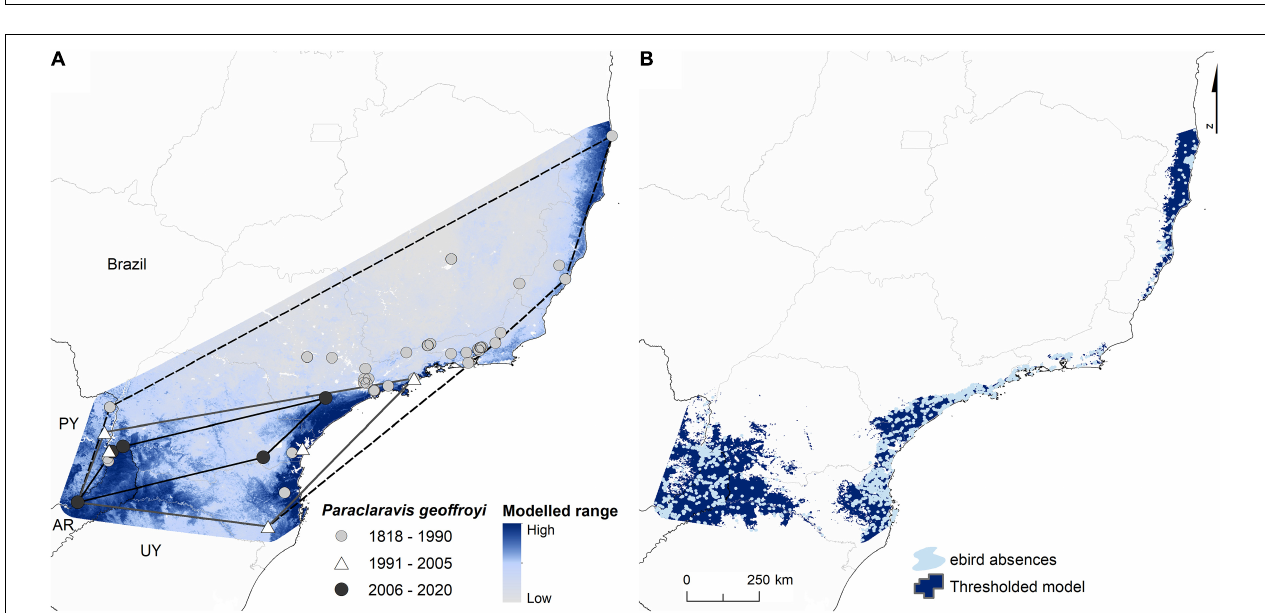
FIGURE 3 | Probability of taxon being extant 1894–2030, for analysis using just specimen records and both specimen records and sight records. The outer gray envelopes show minimum-maximum probability estimates, whereas the inner gray envelopes show mean probability estimates ± standard deviation.